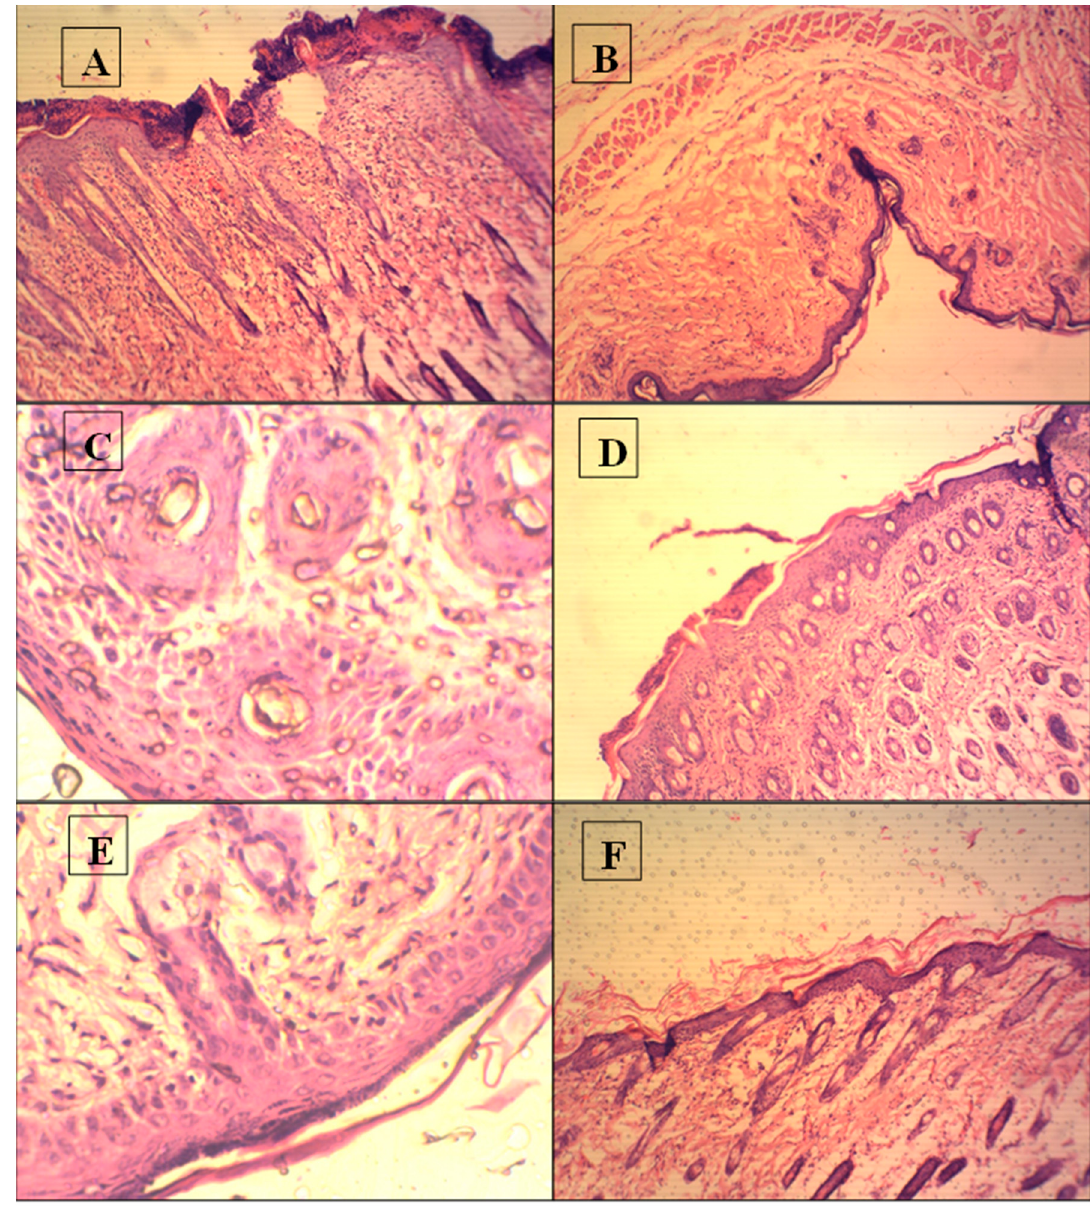
Figure 3. Representative photomicrographs of skin in mice of different groups. ( A ) IMQ-treated mice showing hyperkeratosis, parakeratosis, scale crust, edema, psoriasiform, and hyperplasia. ( B ) clobetasol-treated mice showing orthokeratosis. ( C ) Topical MCBA-treated mice showing hyperkeratosis, parakeratosis, scale crust, hyper granulosis, intact epidermal–dermal junction, focal psoriasiform epithelium, few polymorphs in upper dermis, few extravasates red blood cells, and scattered apoptosis cells in epidermis. ( D ) Topical CBA-treated mice showing mild hyperkeratosis, parakeratosis, scale crust, edema in upper dermis, neutrophils in upper dermis, and focal psoriasiform hyperplasia. ( E ) Oral MCBA-treated mice showing focal mild hyperkeratosis, focal parakeratosis, focal hyper granulosis, and intact epidermal–dermal junction. ( F ) Oral CBA-treated mice showing orthokeratosis, subcutaneous tissue showing pus cells, and necrosis of hypodermis.